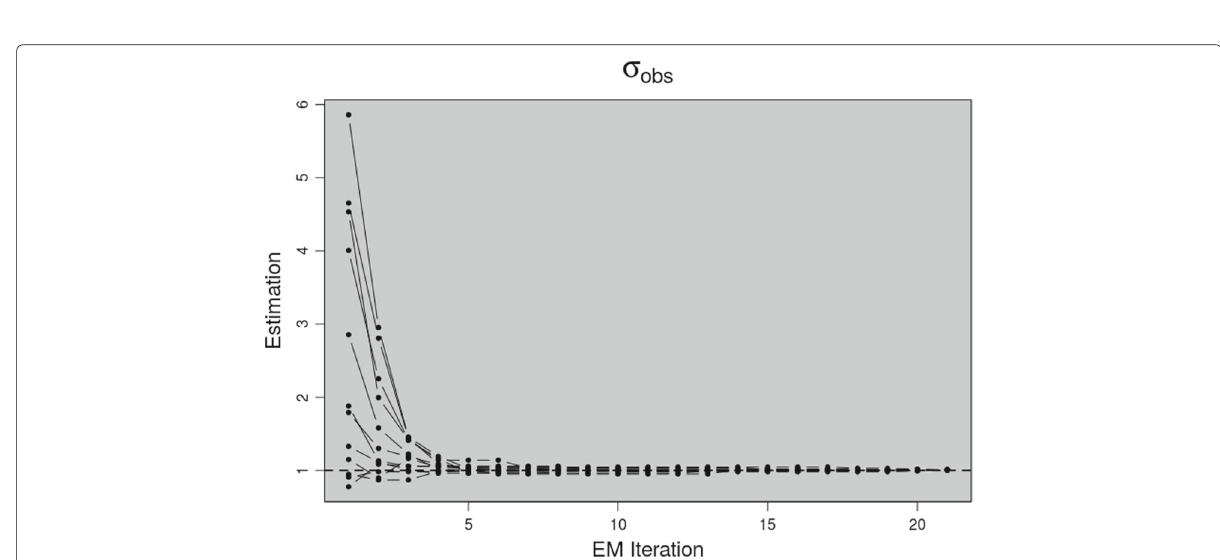
Fig. 7 SINE model - EM. Estimation of σ